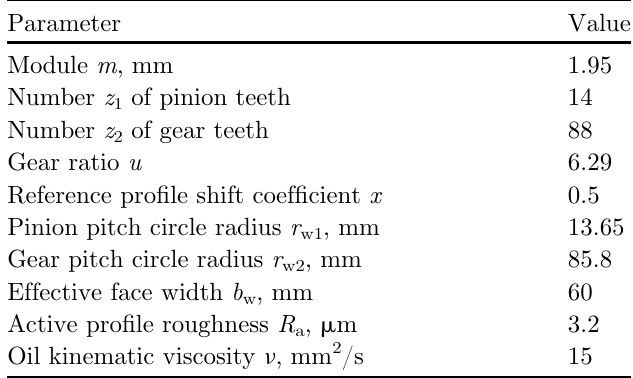
Table 7. Gear pair